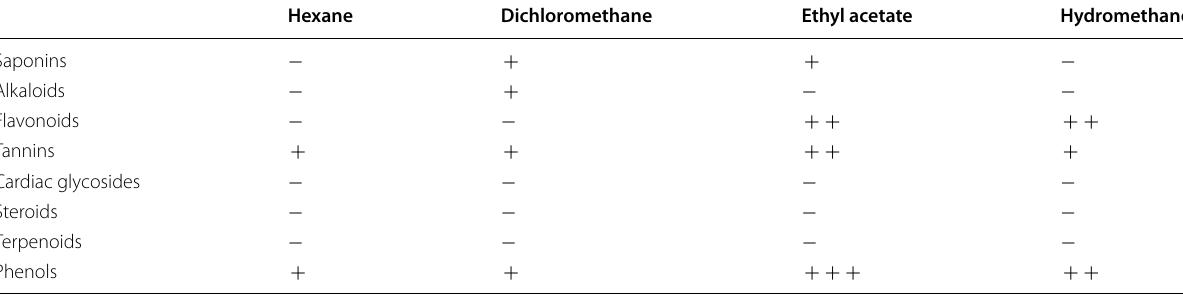
KEY: absent, trace amounts, − = + =